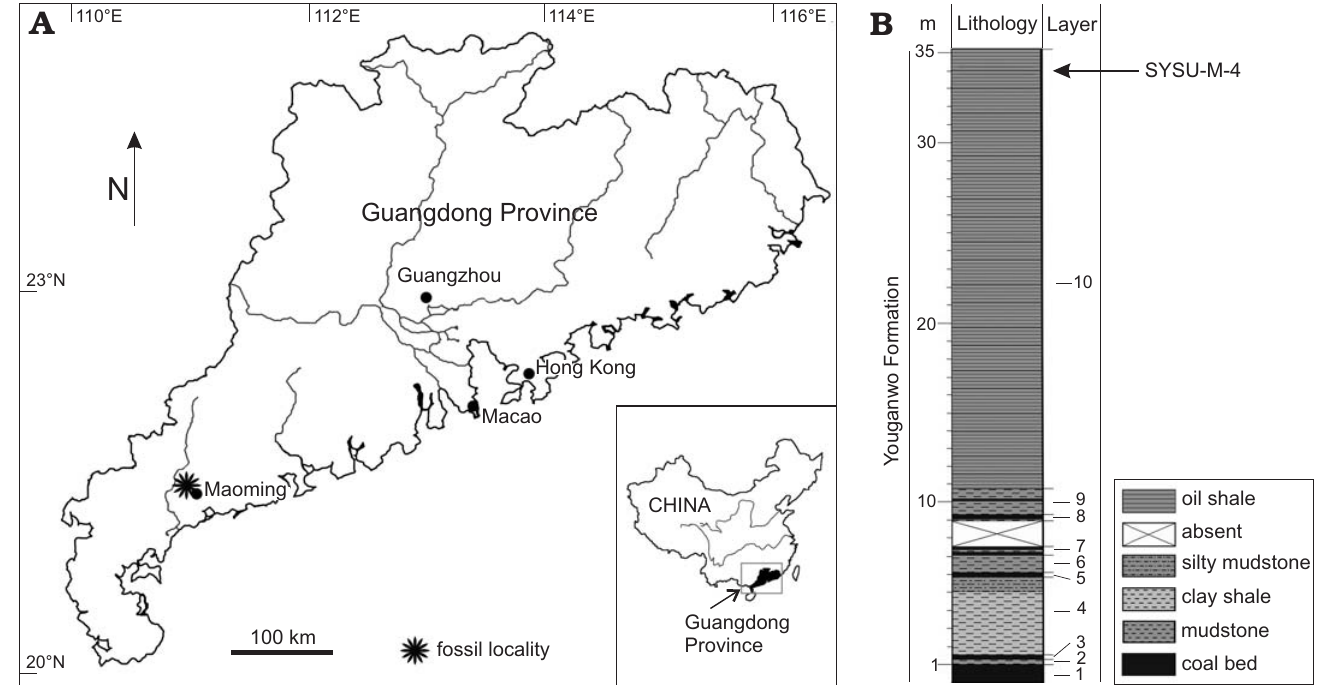
Fig. 1. A . Geographical map of the Maoming Basin, Guangdong Province, China; fossil site where SYSU-M-4 was found is indicated by a star. B . Stratigraphical column of the Youganwo Formation (position of SYSU-M-4 is indicated by an